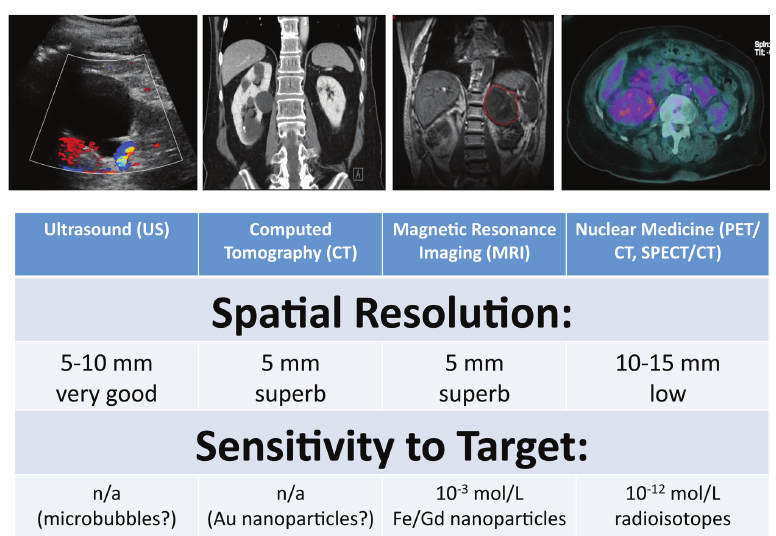
Figure 1. Comparison of different molecular imaging modalities. The anatomic spatial resolution and sensitivity for different molecular imaging methods are shown. CT and MRI based methods have excellent anatomic resolution, whereas PET/CT and SPECT/CT have very high sensitivity for detecting molecular